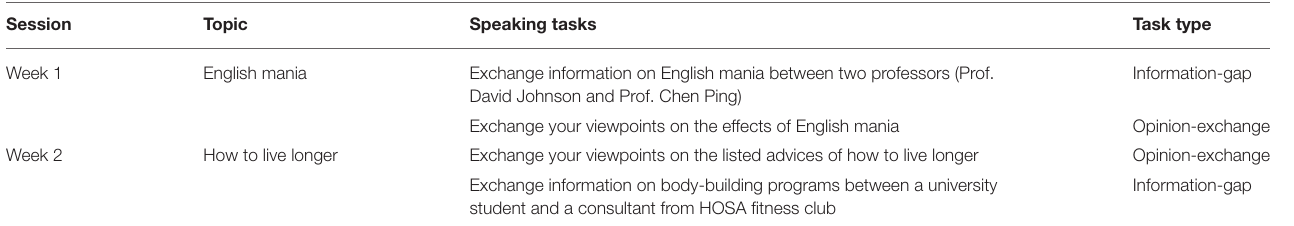
TABLE 2 | The list of speaking